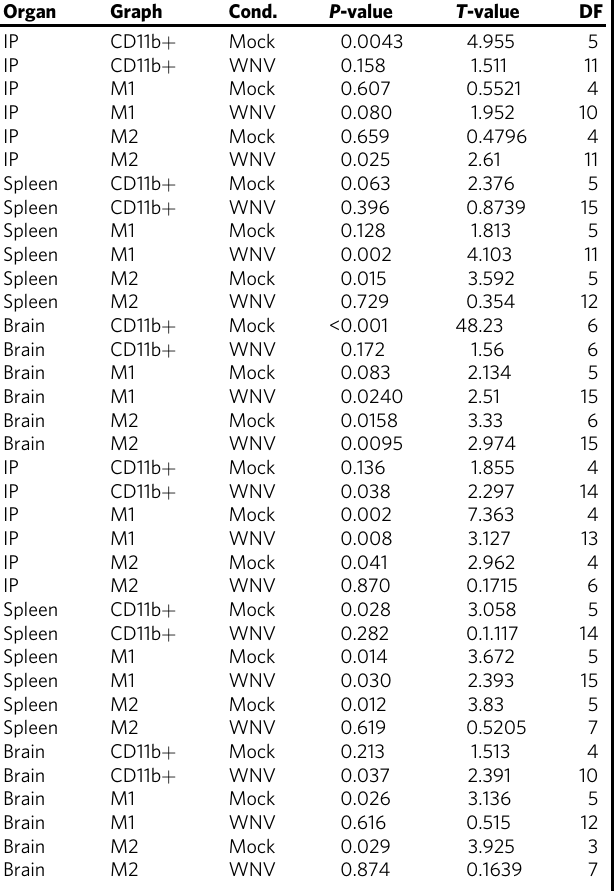
manufacturer ’ s instructions. Arginase activity analysis: BMMs polarized as described above were lysed and analyzed for arginase activity using the QuantiChrom Arginase Assay kit (BioAssay Systems) as per the manufacturer ’ s instructions. For antibodies, mouse lines, and primers, see Table 1.